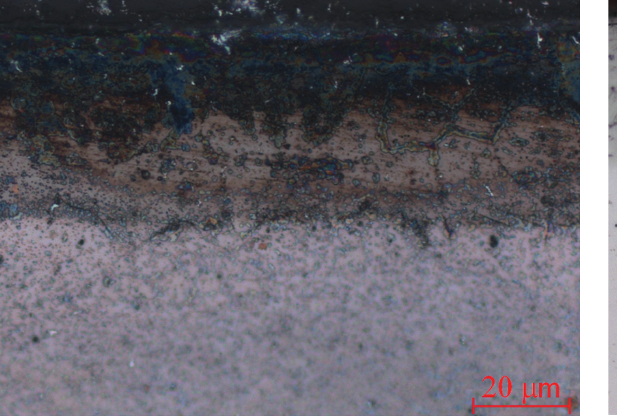
Figure 5: Cross-section of a nitrided sample, treatment time 20 min, nitriding temperature 590°C, sample bias – 500 V, sample current density 3.3 mA/cm 2 , layer microhardness 8.0 GPa.